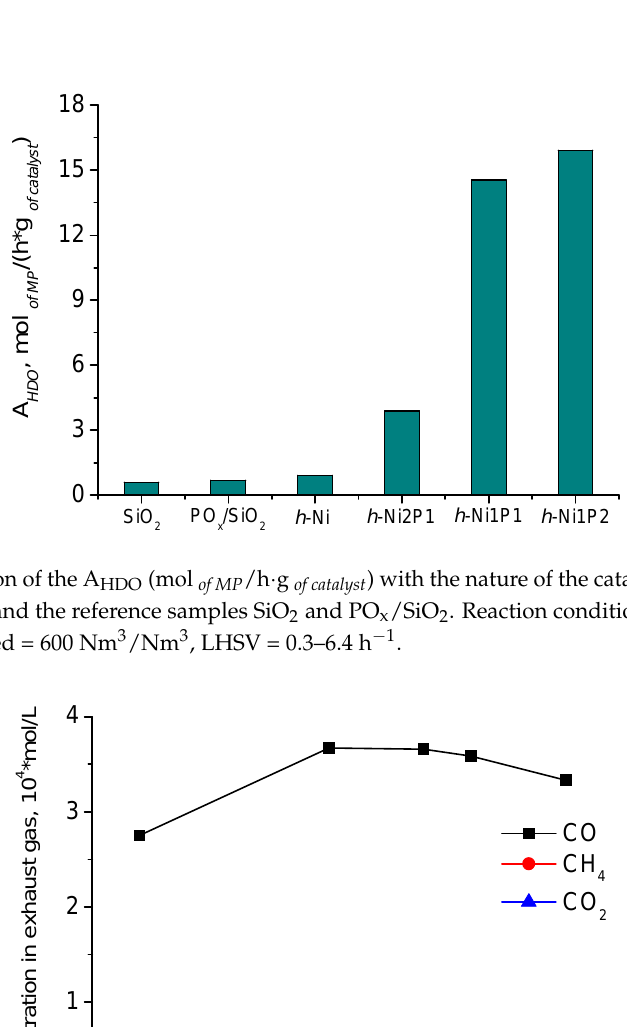
13 of 20 Figure 9. Methyl palmitate (X MP ) and oxygen (X OCC ) conversions versus liquid hourly space velocity (LHSV) of MP (h − 1 ) over the low ‐ loaded nickel phosphide catalysts with different Ni/P molar ratios: l ‐ Ni2P1, l ‐ Ni1P1 and l ‐ Ni1P2. Reaction conditions: P H2 = 3.0 MPa, T = 290 °C, H 2 /feed = 600 Nm 3 /Nm 3 , LHSV = 0.3–6.4 h − 1 . To clarify the routes of acid transformation the additional experiments were done using lauric acid as a model compound. Just only CO was observed in the exhaust gas of lauric acid HDO over the l ‐ Ni1P2 catalyst, wherein CO does not give methane at least up to 360 °C (Figure 11). So, methane observed among the product of methyl palmitate HDO can be produced through the methyl palmitate hydrogenolysis or as a result of methanol hydrogenation. The choice between these two contributions is rather complicated since the quantitative analysis of methanol is failed due to its hydrophilicity causing the agglomeration of methanol with the produced water.